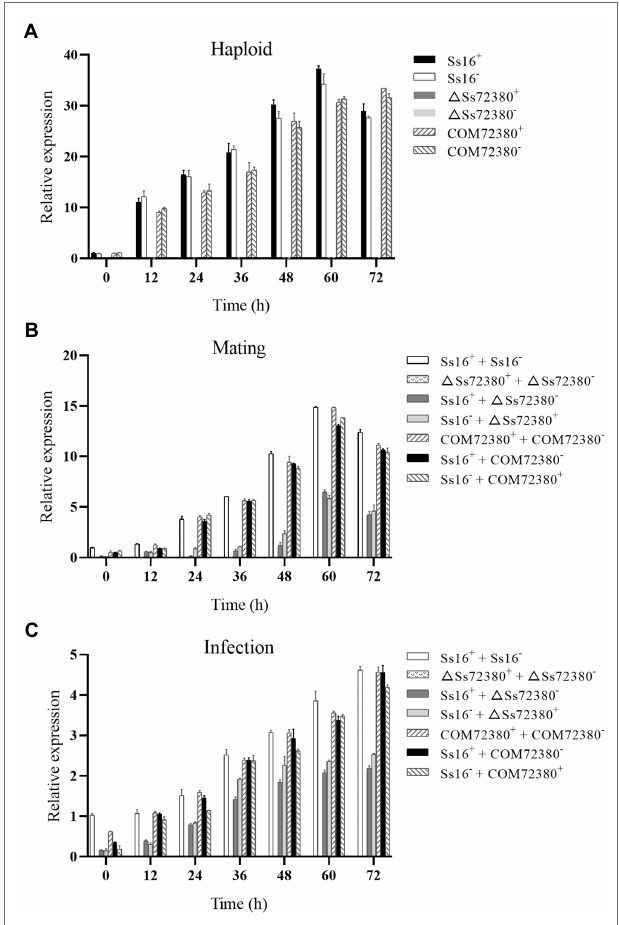
FIGURE 7 | Expression analysis of SsCI72380 during various stages. (A) Gene expression levels under sporidial growth. (B) Gene expression levels under sexual mating conditions. (C) Gene expression levels under sugarcane bud infection. SsCI72380 expression at 0 h was normalized to one. Bars indicate the SE. The analyses were repeated three